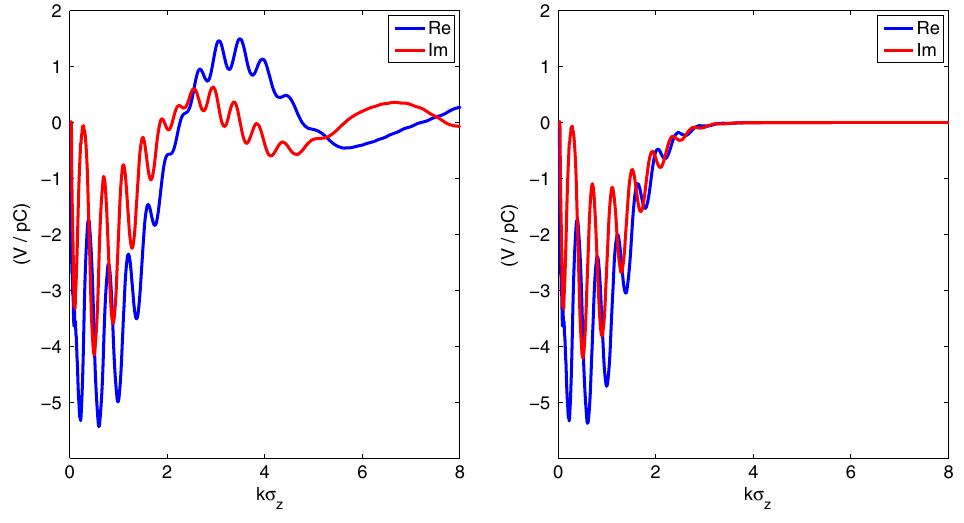
FIG. 20. Fourier transforms of the two wakefields of Fig. 19.